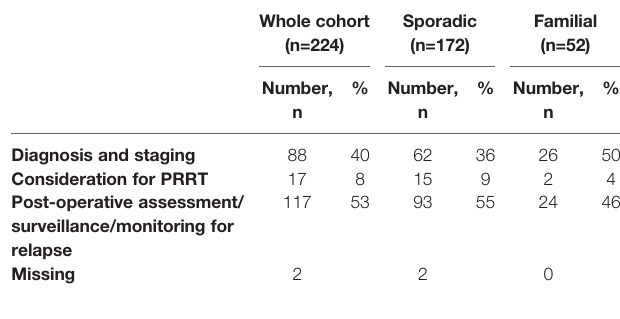
TABLE 4 | Rationale for performing Ga 68 DOTA PET/CT